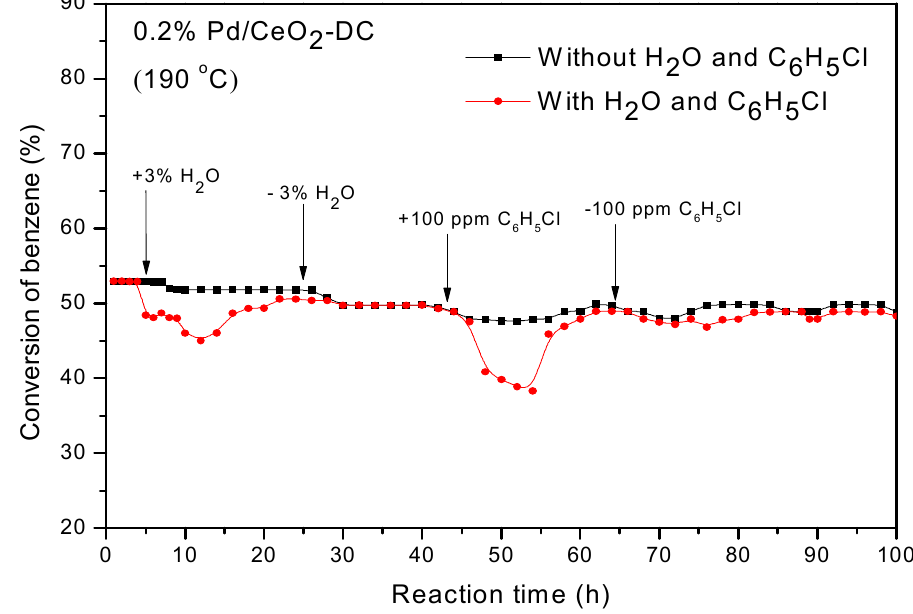
Figure 2. Durability test for catalytic combustion of benzene over the 0.2% Pd/CeO 2 -DC catalyst.